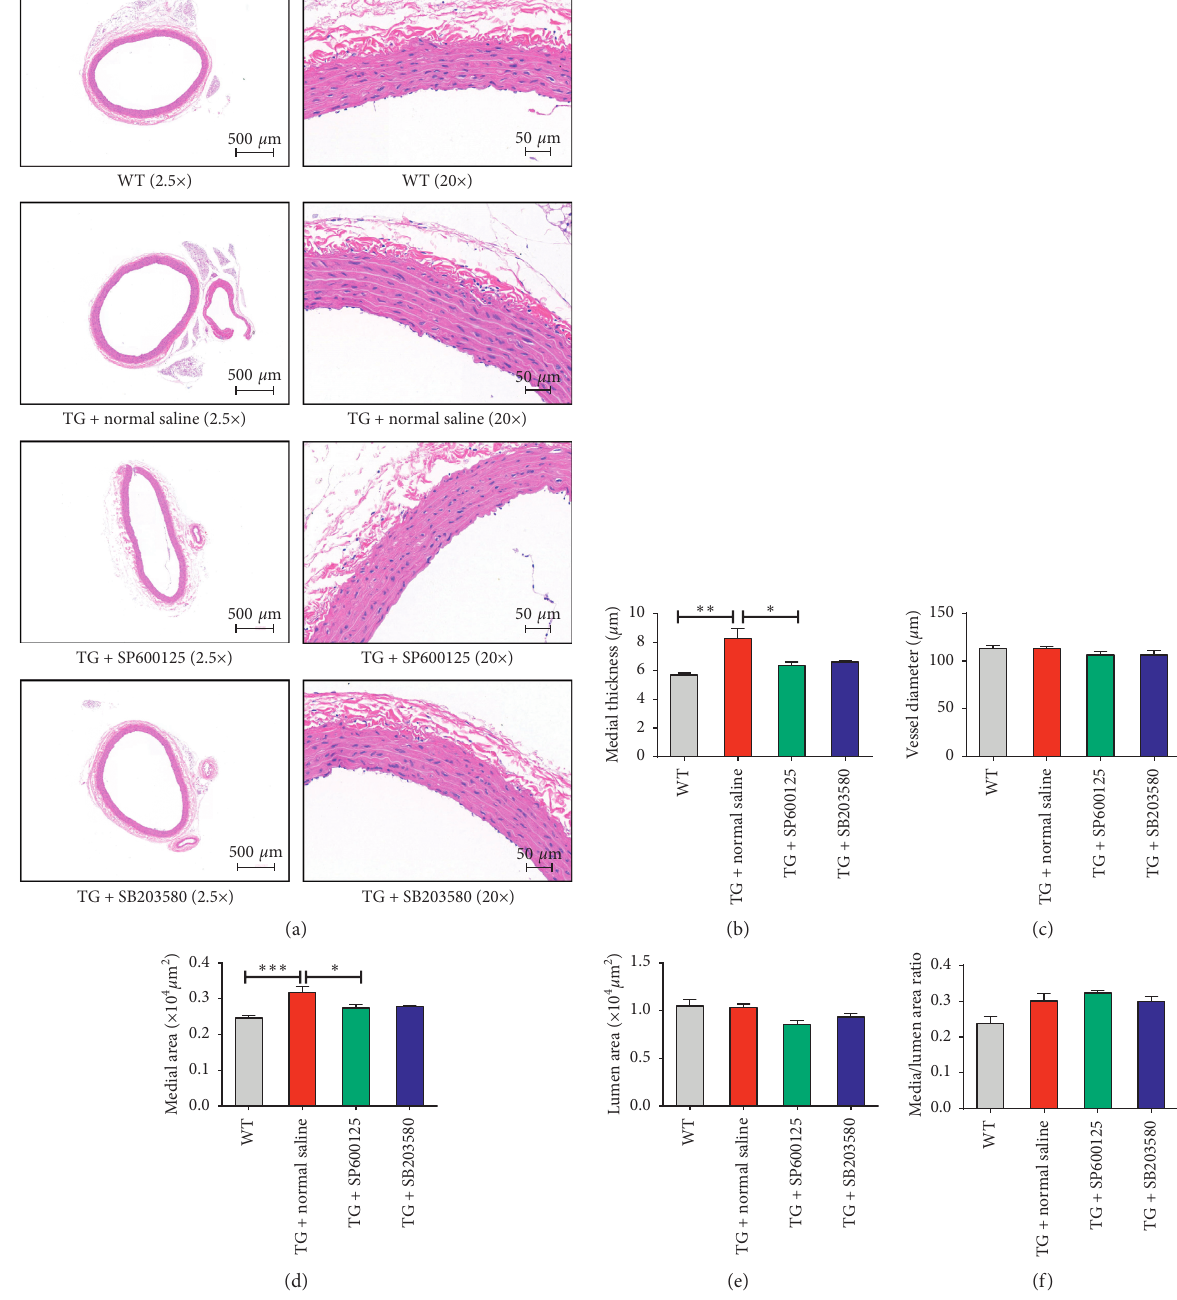
Figure 2: p38/JNK was required for vascular remodeling mediated by L3MBTL4 . (a) Representative photomicrographs of hematoxylin- eosin staining in blood vessels from WTs, TG+normal saline, TG+SP600125, and TG+SB2003580 ( n � 5 each group). (b)–(f) The media thickness, vessel diameter, media area, lumen area, and media/lumen area ratio of aortas in each group was quantified ( n � 5 per group). The magnification was 2.5-fold and 20-fold. Scale bars are 50 μ m and 10 μ m. ∗ p < 0 . 05; ∗∗ p < 0 . 01; ∗∗∗ p < 0 . 001. All data represent mean ±